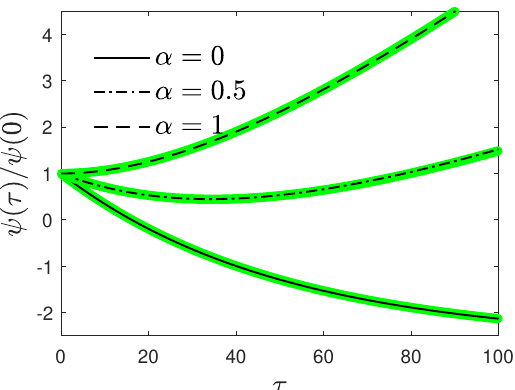
Figure 3. Comparison of the approximant (80) for ψ ( τ ) / ψ 0 with the exact solutions (59) and (61) (black curves) for three different α values at η = 10 − 6 and a relatively low b = 0.02. For the approximant (green), ψ m and τ m are given by Equations (71) and (74), respectively. For larger b the performance of the approximant is even